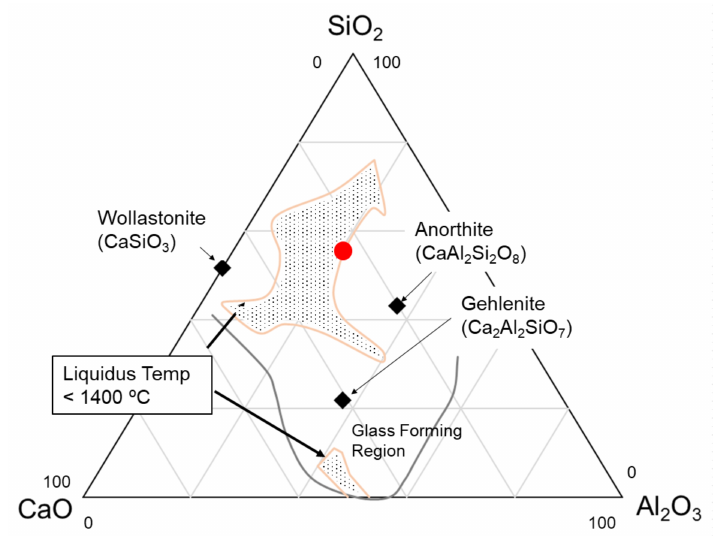
Figure 3. Glass-forming and low-liquidus-temperature region in the CAS system